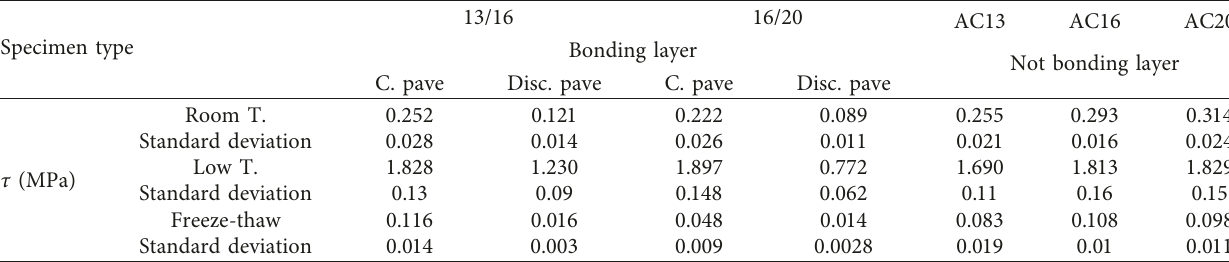
Table 9: Summary of interlayer adhesion test results.